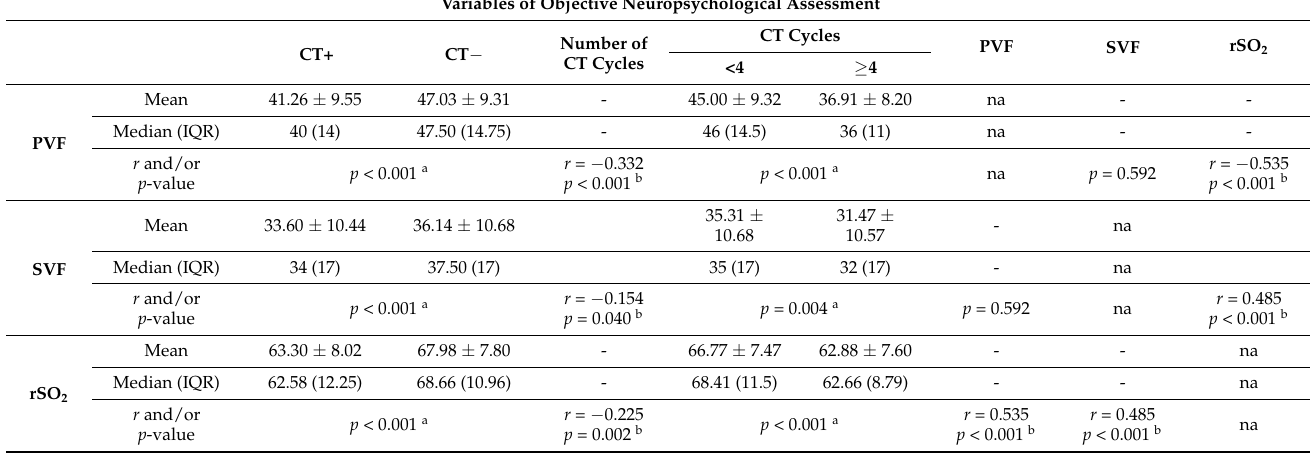
Table 5. Relationships between CT (+, − ) groups and objective neuropsychological assessment variables. Variables of Objective Neuropsychological